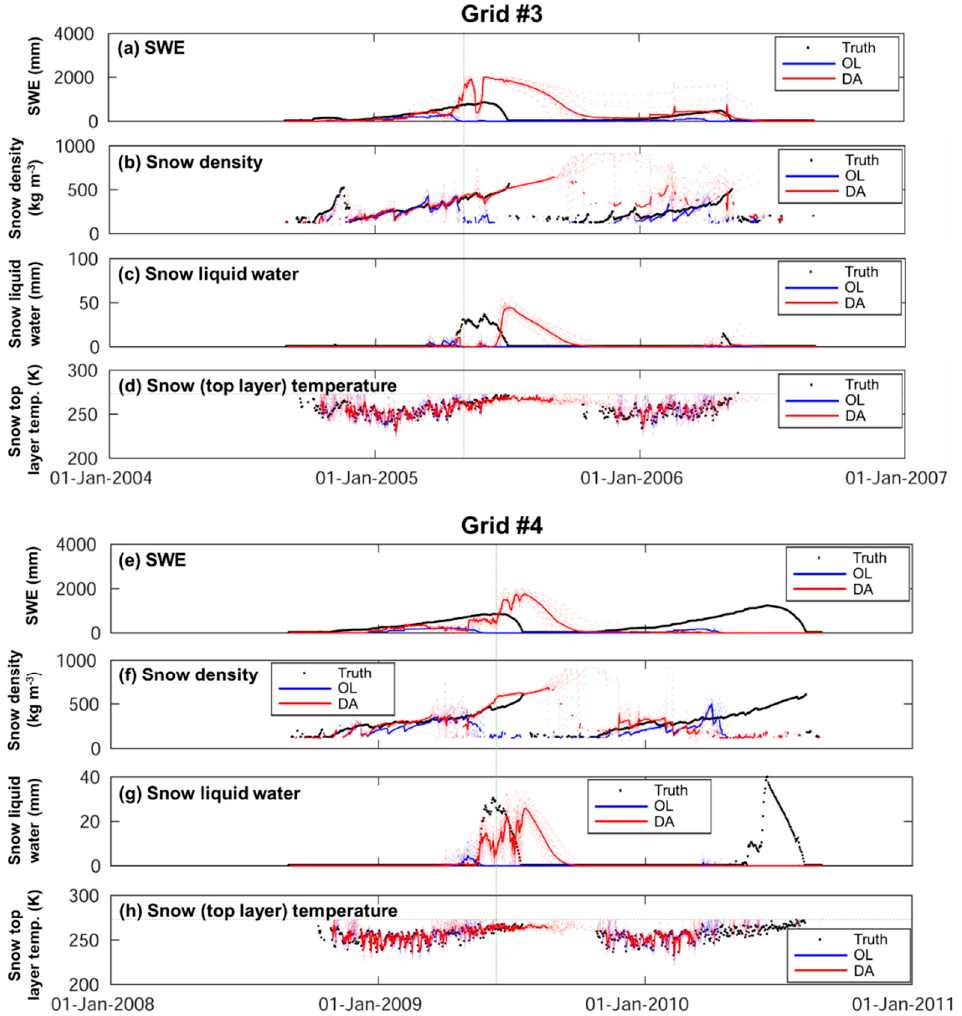
Figure 5. Time series of SWE ( a , e ), snow density ( b , f ), snow liquid water ( c , g ), and snow (top layer) temperature ( d , h ) including the synthetic truth (black dots), OL ensemble mean (blue line), and DA ensemble mean (red line) for Grid #3 and Grid #4. The dotted lines denote the ensemble range of the simulated snow states.